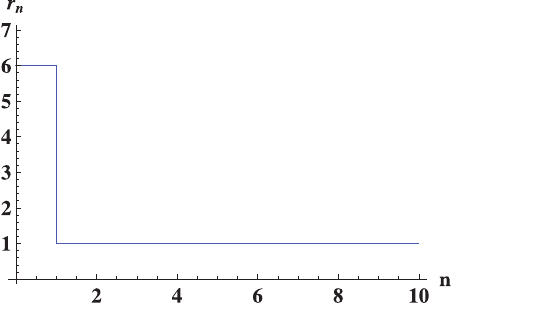
Figure 1. Fitness r n versus Hamming distance n from the peak sequence for the single-peak fitness landscape.